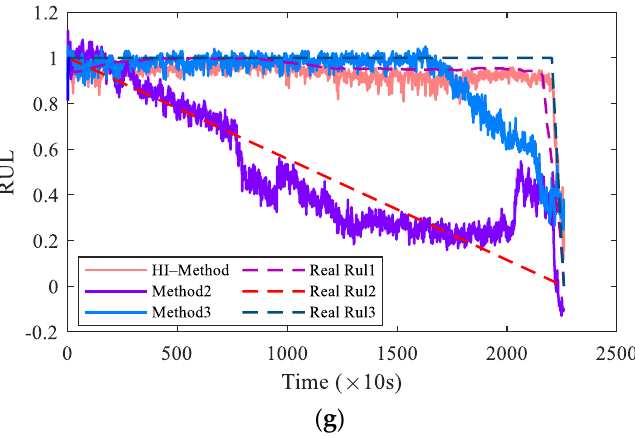
Figure 15. The prediction effect of the model trained by three ways of adding labels: ( a ) Bearing1_1, ( b ) Bearing1_2, ( c ) Bearing1_3, ( d ) Bearing1_4, ( e ) Bearing1_5, ( f ) Bearing1_6 and ( g ) Bearing1_7.